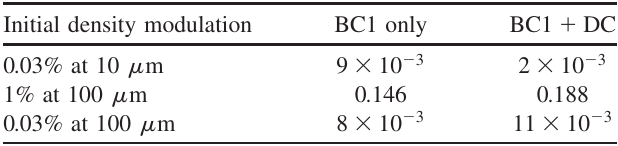
TABLE III. Bunching factor at the end of compression for the BC1 only and the BC1 þ DC compression scheme. The total compression factor is 3.5 in both cases.